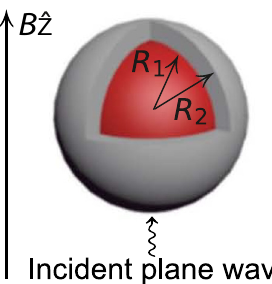
Figure1: Schematicviewofthesphericalsetupconsistingofahigh- indexdielectriccore(radius R 1 )coatedbyaDrude – Lorentzmagneto- optical shell (outer radius R 2 ). The external magnetic bias B is z -oriented, while the incoming plane wave impinges along the positive O z